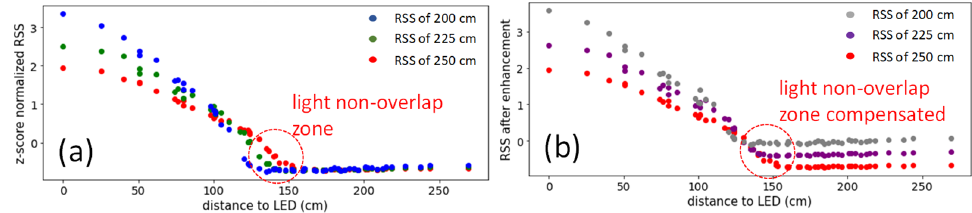
Figure 6. ( a ) LED 1 light distribution profile in each Rx plane. ( b ) The LED1 light distribution profile after RISE.